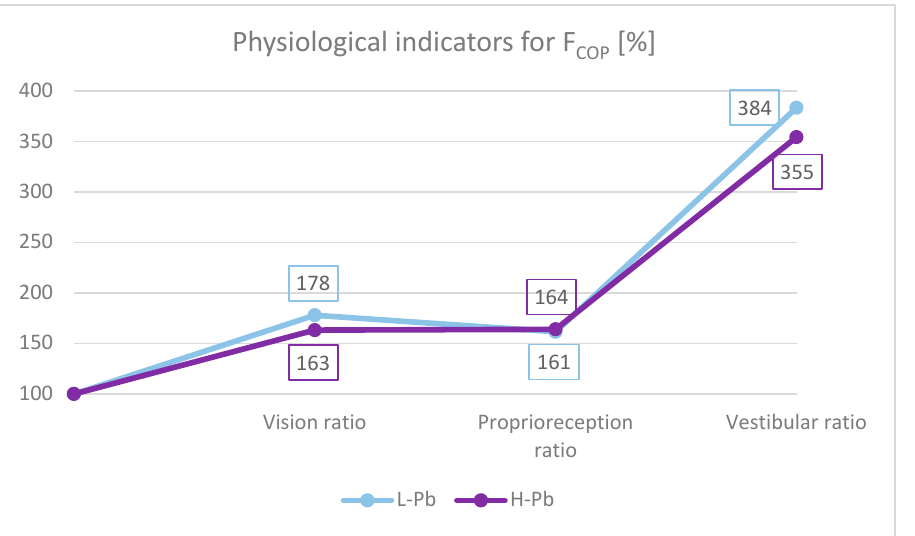
Figure 3. F COP indicators: vision ratio, proprioreception ratio and vestibular ratio. L-Pb—low-PbB- level subgroup, H-Pb—high-PbB-level subgroup. The chart shows the values of the indicators in percent. Calculations based on the values in Table 3.